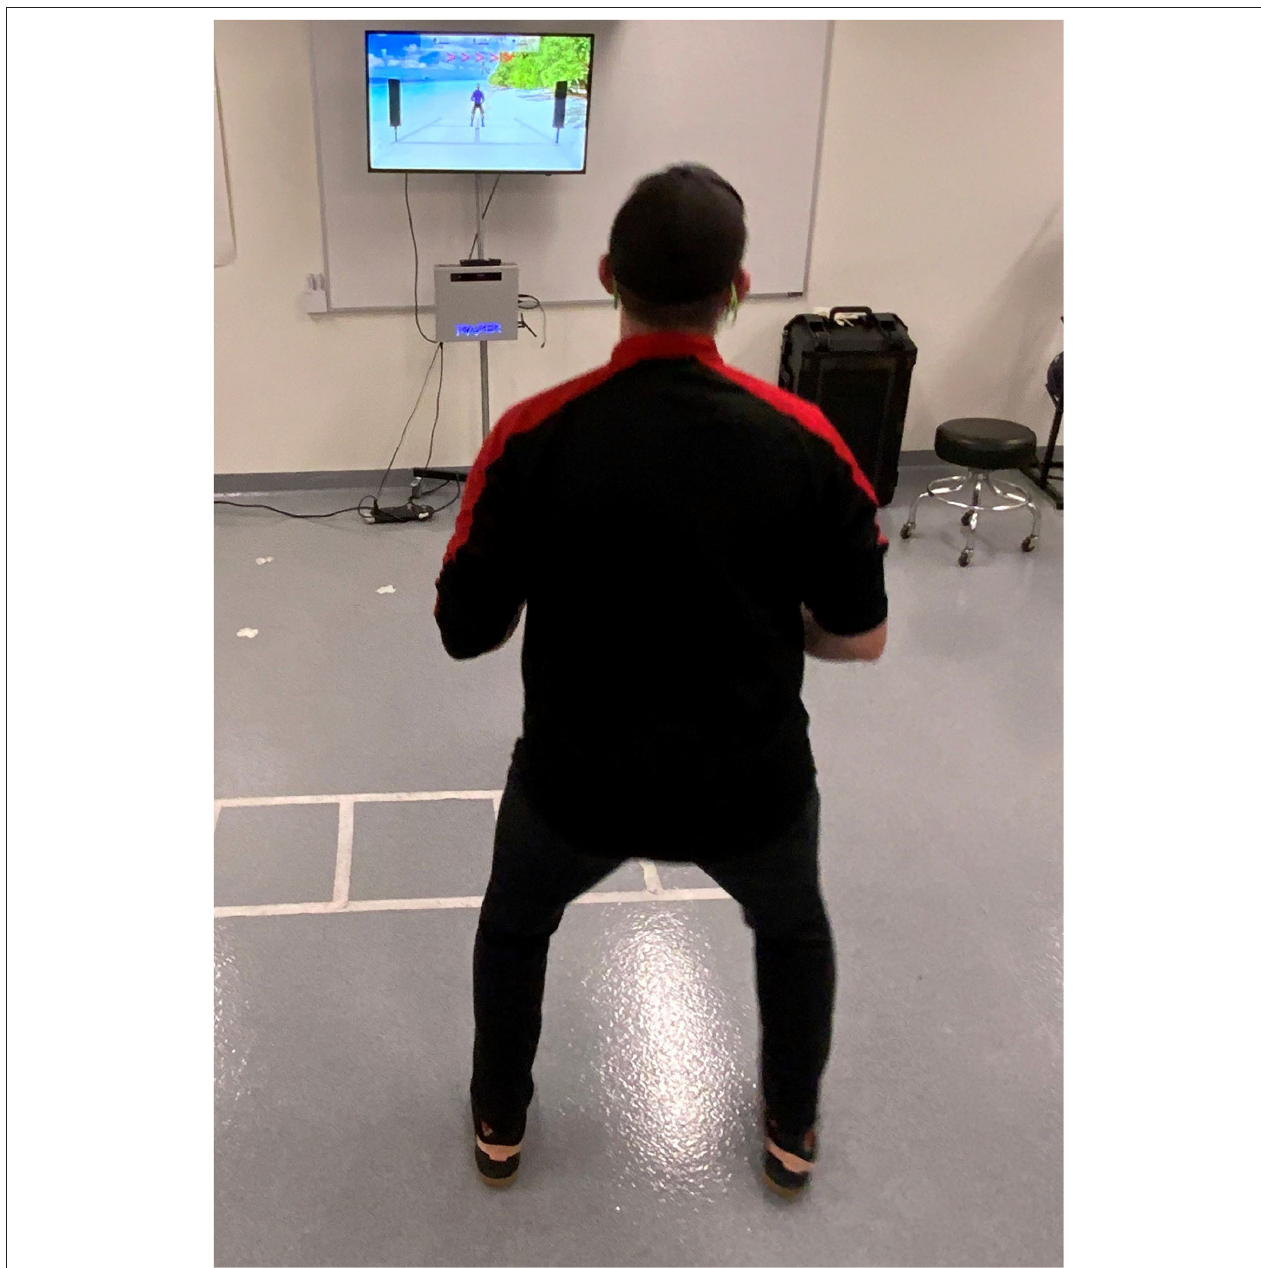
FIGURE 2 | A student-athlete being assessed for their WBRA metrics.